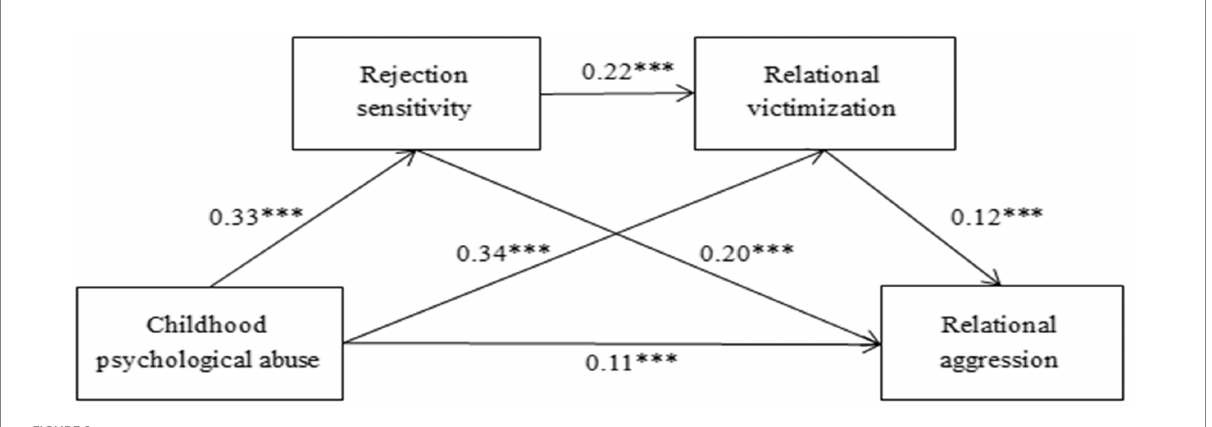
FIGURE 2 The chain mediating effect of rejection sensitivity and relational victimization, *** p